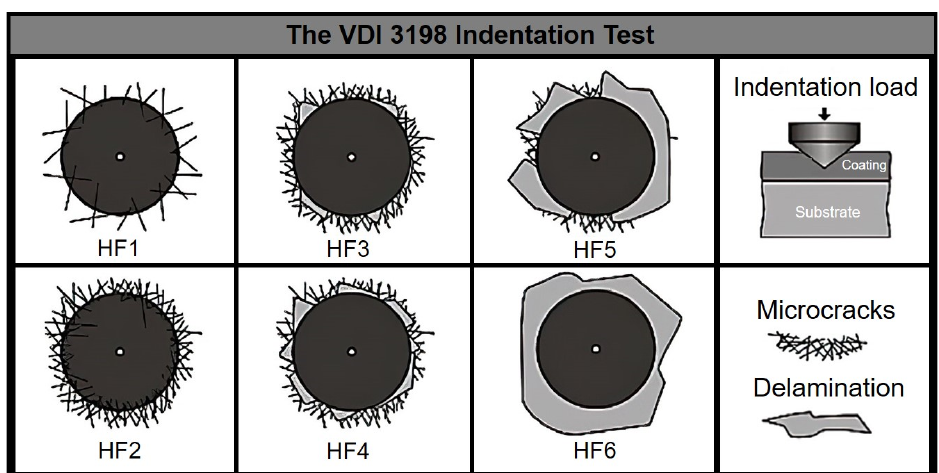
Figure 1. Combine strength rating criteria.